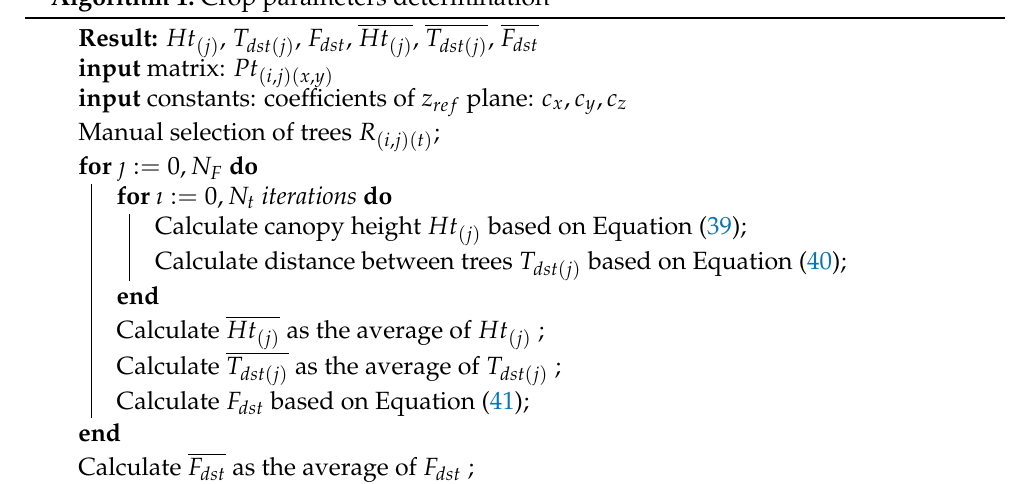
Algorithm 1: Crop parameters determination